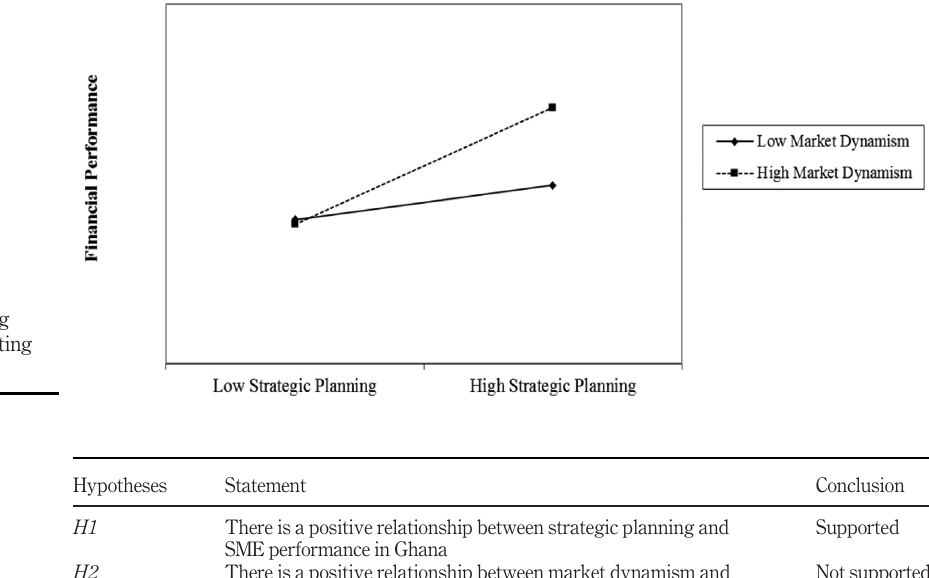
Table V. Hypotheses test